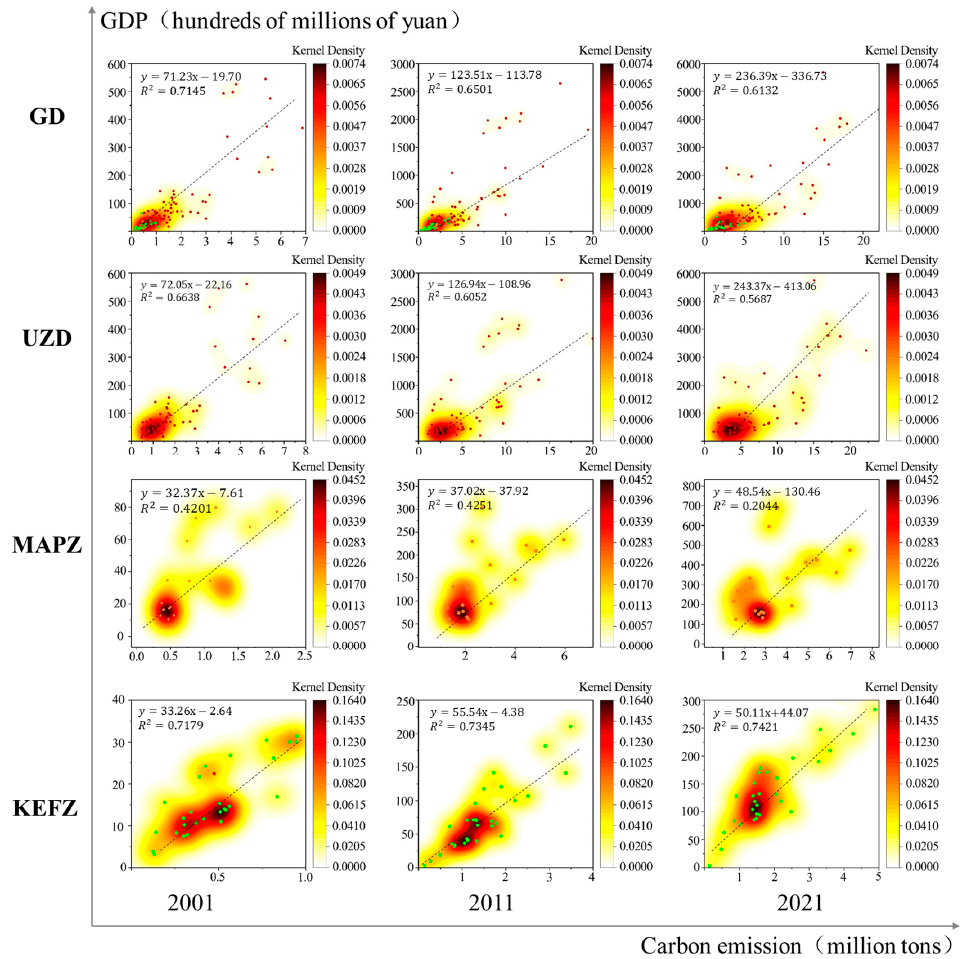
Figure 7. Correlation between carbon emissions and GDP in Guangdong Province and in the three types of MFOZs from 2001 to 2021.